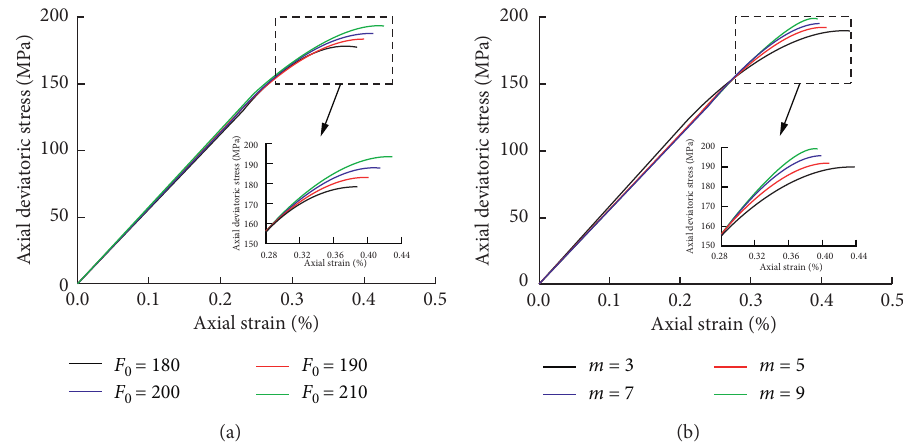
Figure 6: The influence of Weibull parameters on the stress-strain curve in the prepeak stage: (a) different F